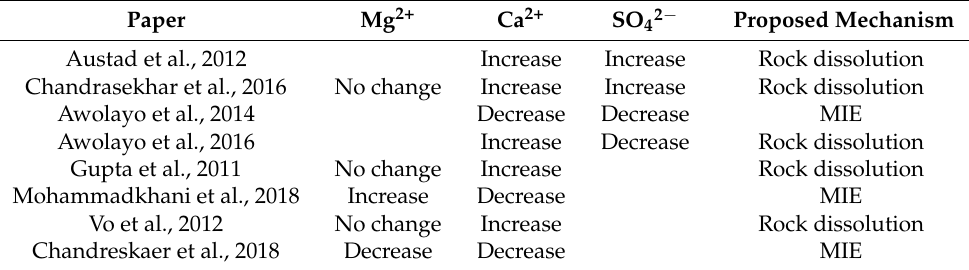
Table 9. Proposed mechanisms based on PDI concentration change.